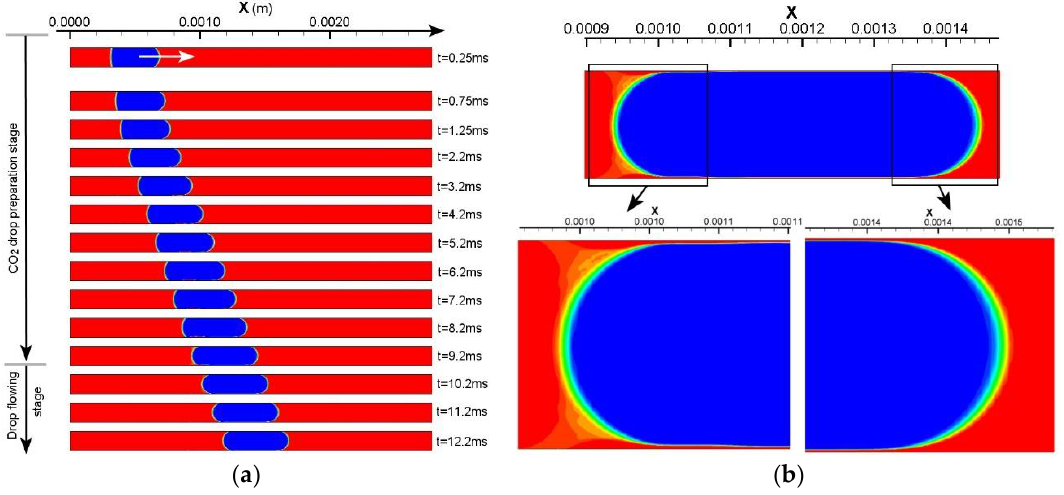
Figure 2. ( a ) The CO 2 drop preparation stage of simulation case 1. Duration of this stage is Δt 0 = 9.2 ms. ( b ) A completely cylindrical CO 2 drop with two meniscuses is formed at t = 9.2 ms. Thin water film (as shown below) is 2~2.3 µm thick, compared to a 150 µm channel width. Red color indicates the volume fraction of water α H2O = 1, blue color indicates α H2O = 0 (i.e., α CO2 = 1).